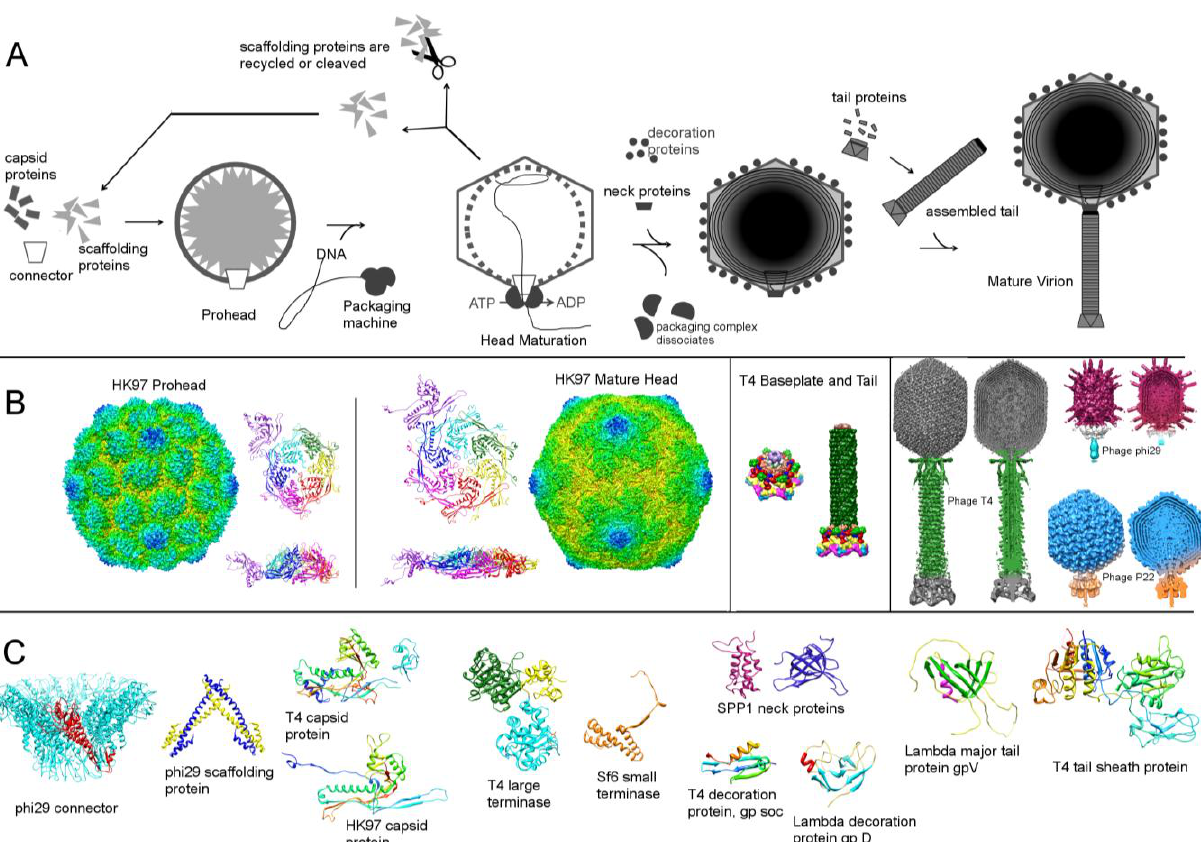
Figure 2. Assembly of dsDNA tailed phages. ( A ) Schematic of the assembly steps. ( B ) Examples of assembly intermediates and mature virions. The left panel shows